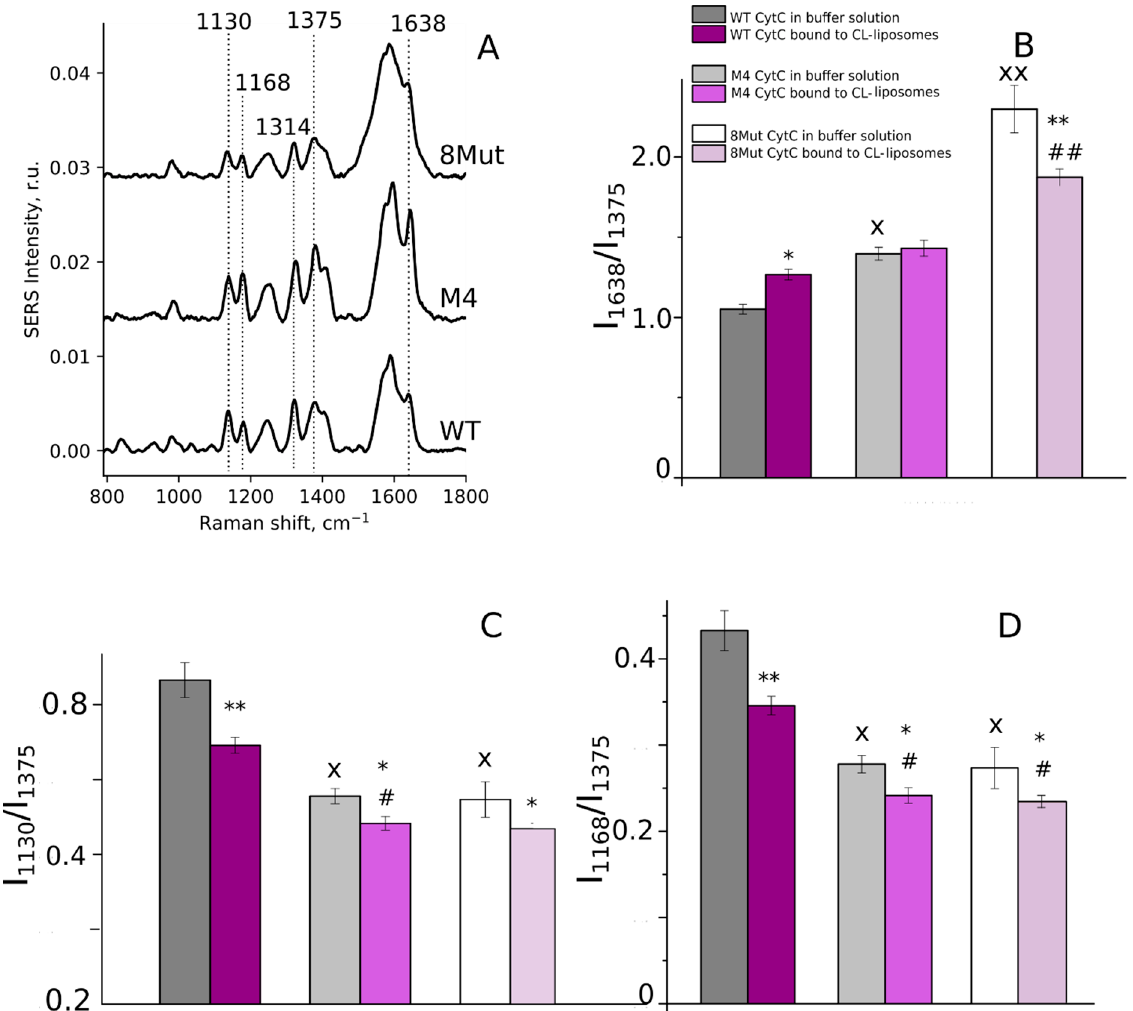
Figure 5. ( A ) SERS spectra of oxidized WT, M4, and 8Mut cytochrome c (1 mM) in the phosphate buffer. For clearer presentation, spectra are normalized to the sum of all spectrum intensities and shifted vertically. Dotted lines show the maximum positions of the most intensive peaks used for the heme conformation analysis. ( B – D ) Ratios of peak intensities calculated from the SERS spectra of WT CytC and its mutants with four and eight site-directed mutations in buffer solution (dark grey, light grey, and white boxes, respectively) and in the membrane-bound state in CL-containing liposomes (dark violet, bright violet, and light violet boxes, respectively). The I 1638 /I 1375 ratio corresponds to the probability of the plane heme conformation ( B ), the I 1130 /I 1375 ratio corresponds to the probability of the heme CH 3 -group vibrations ( C ), and the I 1168 /I 1375 ratio corresponds to the probability of asymmetric pyrrol ring vibrations vs their symmetric vibration. Data are presented as mean values and the error of the mean, n = 7. Statistics were evaluated with ANOVA (GraphPad Prism 8.0). * p < 0.05, ** p < 0.01 for the specified ratios calculated for a certain CytC form bound to CL-containing liposomes compared to this CytC form in the buffer. # p < 0.01, ## p < 0.001 for the specified ratios for M4 and 8Mut in liposome-bound state compared to WT CytC in the liposome-bound state. × p < 0.01, ×× p < 0.001 for the specified ratios for M4 and 8Mut in the buffer compared to WT CytC in the